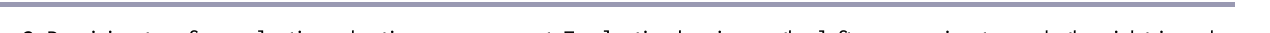
Fig. 2 . Decision tree for evaluating adaptive management. Evaluation begins on the left progressing towards the right in order to establish the suitability of AM application, its feasibility, and its ultimate success. Stage 1 relates solely to the goal of reducing ecological uncertainty and the appropriateness of using AM to attain that goal. Stage 2 emphasizes the need to consider the feasibility of AM in terms of resource constraints as well as the specific social, political, and institutional context of management. Alternatives to AM are likely to be conventional resource management methods and/or tools specifically intended to resolve political, social, or institutional obstacles to successful resource management. Stage 3 indicates where AM may be legitimately